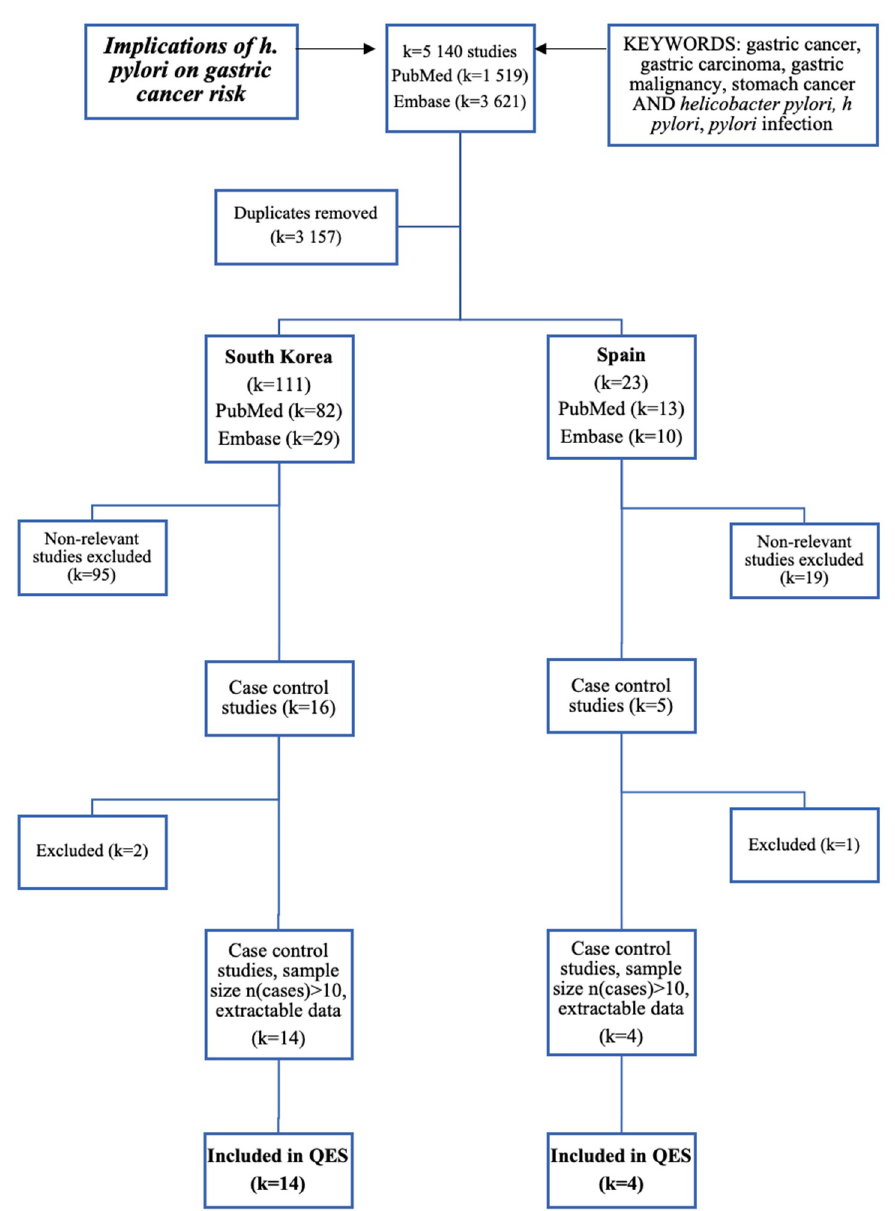
Figure 1. A schematic representing the inclusion or exclusion of studies from the QES. All studies were published between 1997–2018 and were located using the described search terms. In total, 14 studies from South Korea were included, and four studies from Spain were included.